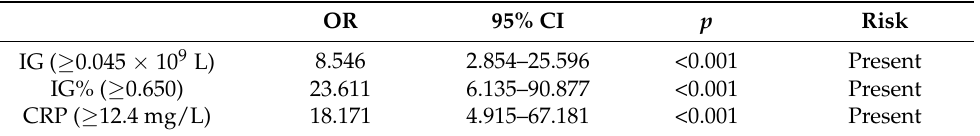
Table 5. Risk analysis for COVID-19 diagnosis with logistic regression analysis in patients presenting with dyspeptic